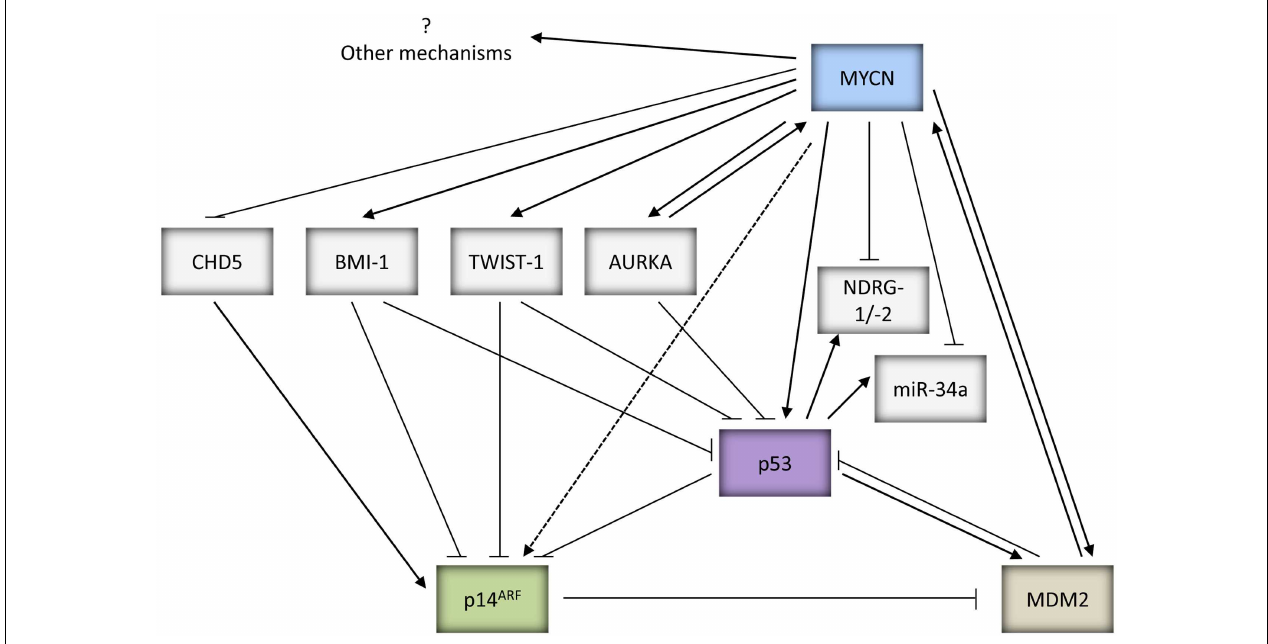
FIGURE 2 | Summary of the potential mechanisms by which MYCN can both positively and negatively regulate p53 activity and function.